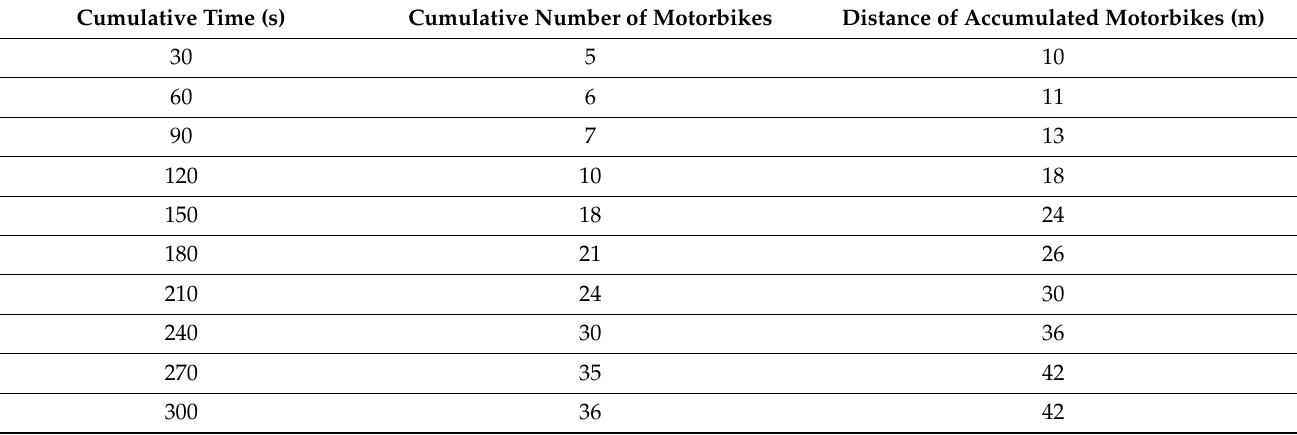
Table 4. The cumulative number of motorbikes in a real traffic accident.